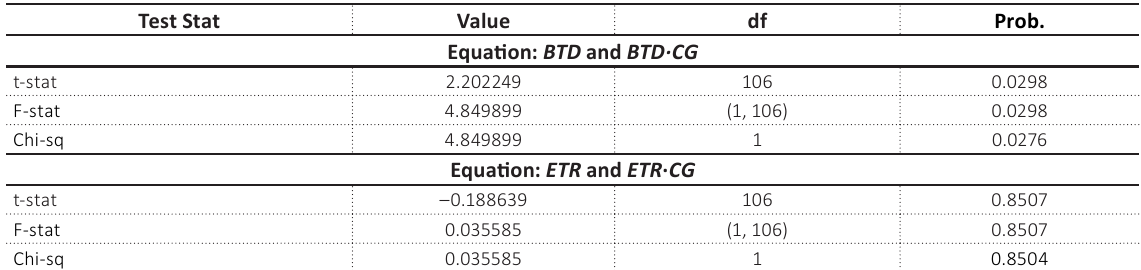
Table 4. Wald test